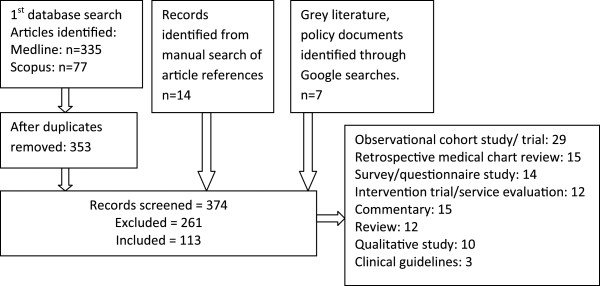
Search strategy one.